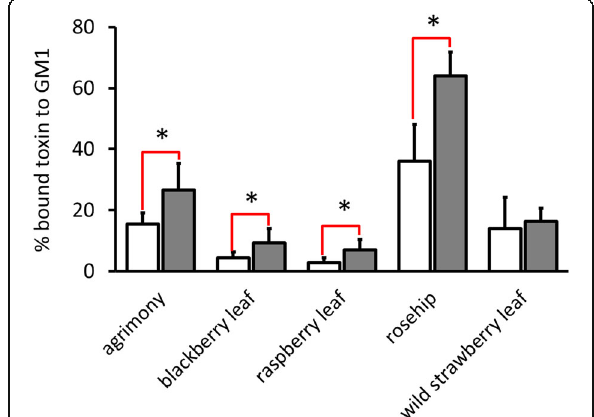
Fig. 3 Plant extract interference in the cholera toxin recognition of GM 1 receptors. Comparison of 2.5 mg/mL plant extract activities preventing the binding of subunit B of cholera toxin (white) and cholera toxin (gray) to immobilized GM 1 . Values are means ± standard errors of six independent assays, p < 0.01, compared with untreated CTX or CTB bound to receptors (100%) for all data; * p < 0.01, for differential response of a plant extract on the binding of CTX or CTB to GM 1